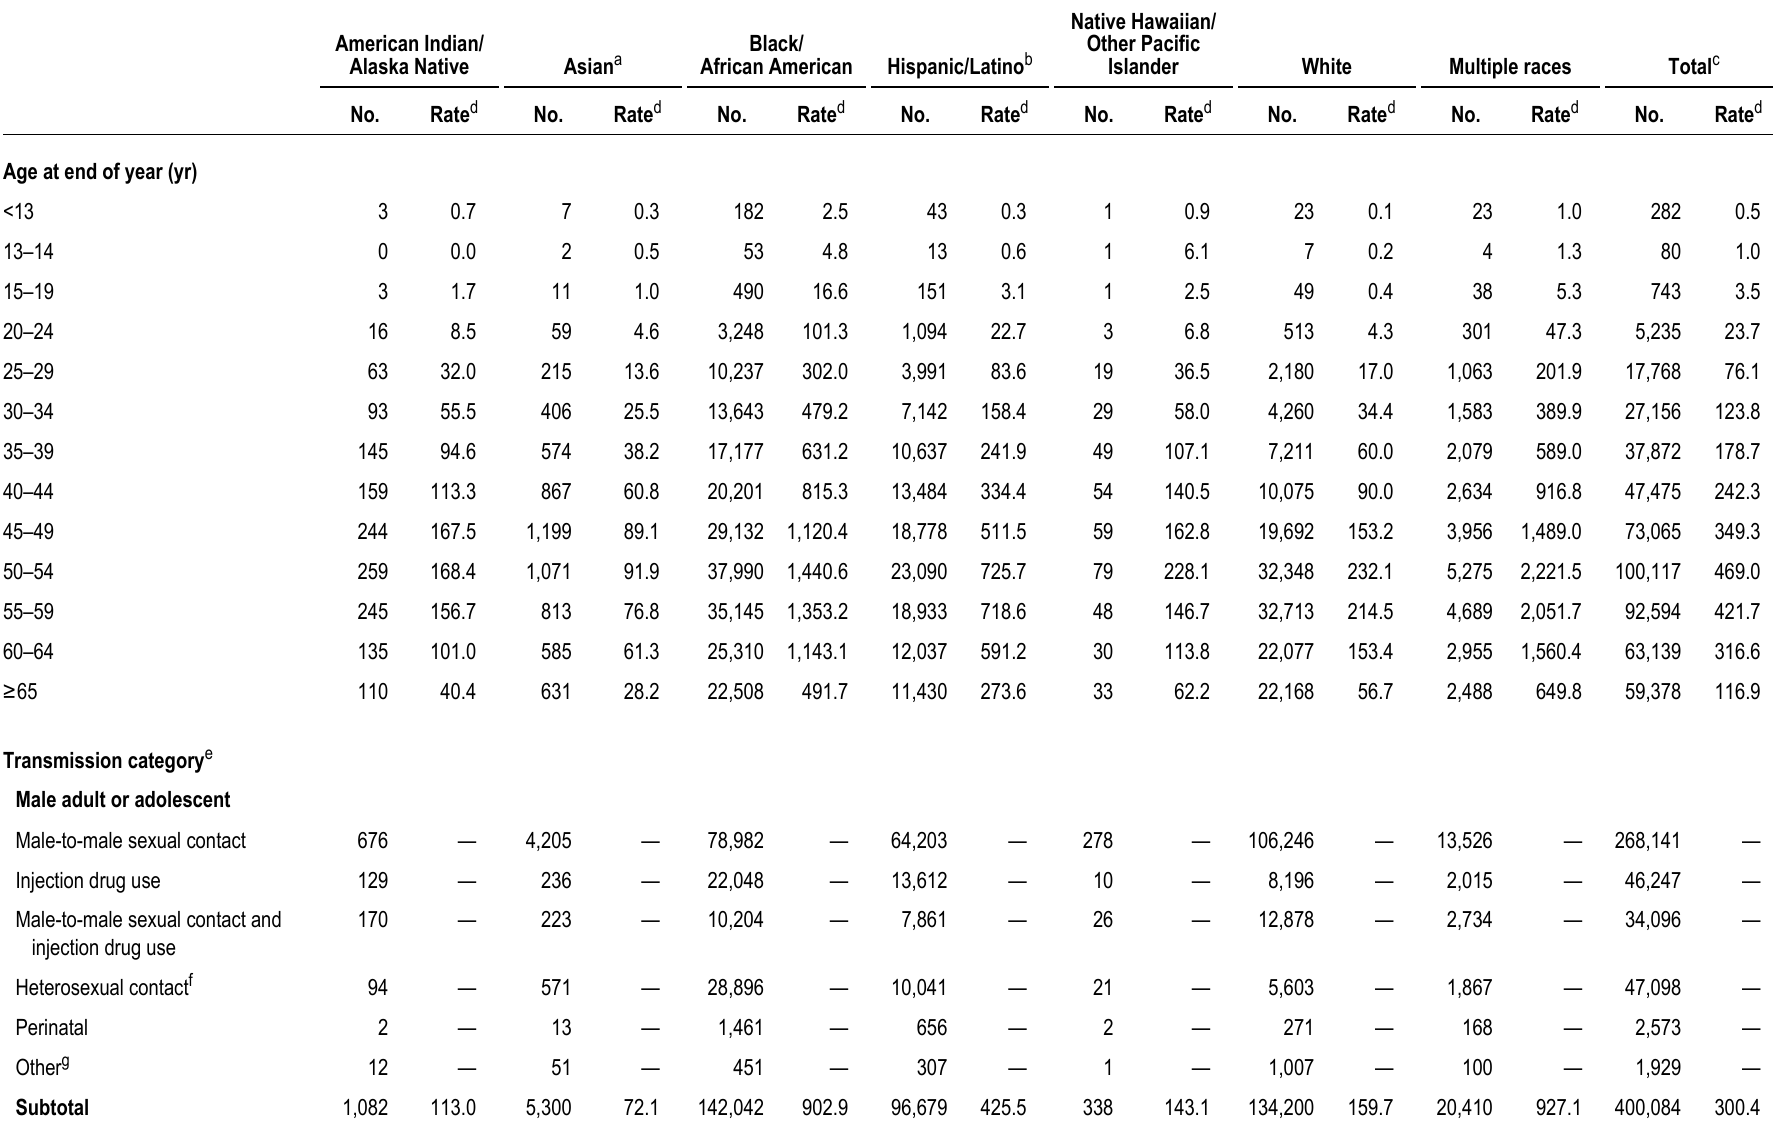
Table 25a. Persons living with diagnosed HIV infection ever classified as stage 3 (AIDS), by race/ethnicity and selected characteristics, year-end 2017—United States Native Hawaiian/ American Indian/ Black/ Other Pacific Alaska Native Asian a African American Hispanic/Latino b Islander White Multiple races Total